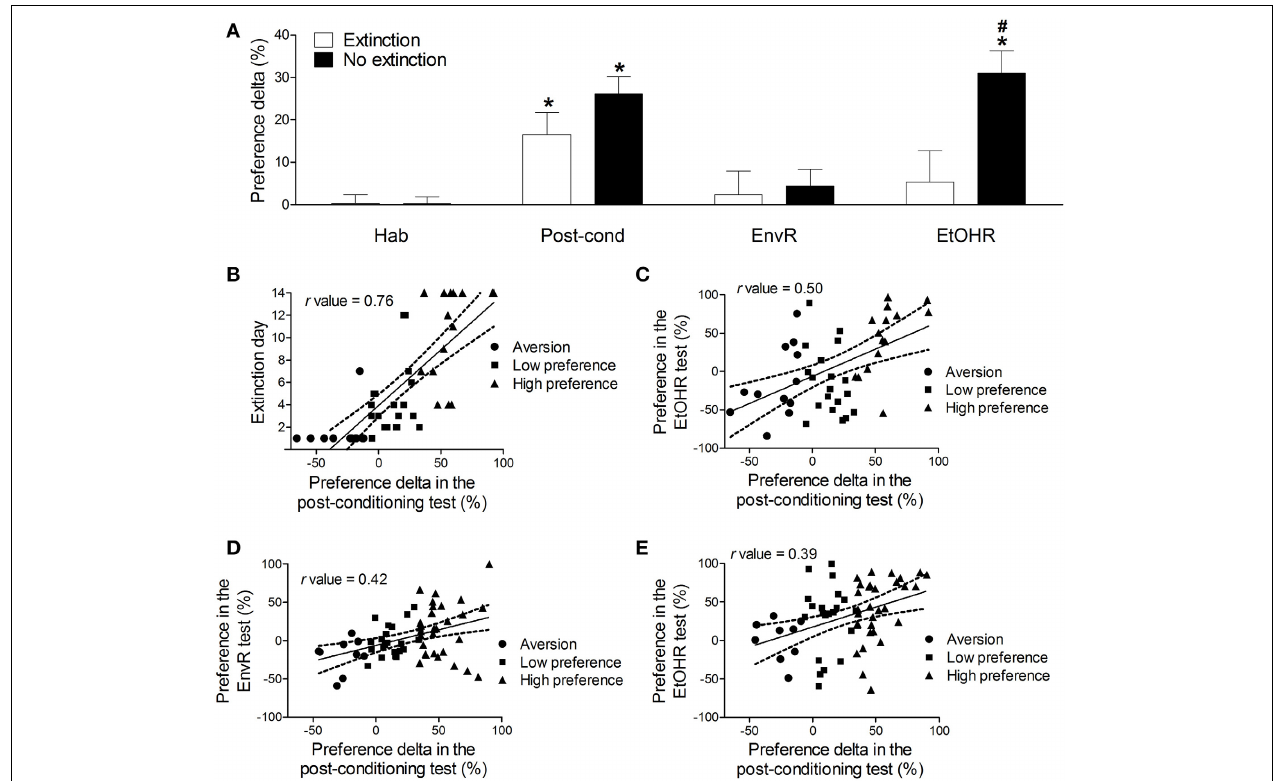
FIGURE 1 | (A) Preference delta for the CS + compartment (mean ± s.e.m) of mice conditioned with 2.2g/kg ethanol from Experiment 2 extinction protocol ( n = 47) and no extinction protocol ( n = 61) in the habituation (Hab), post-conditioning test (Post-cond), environmental reinstatement (EnvR) and ethanol “priming” reinstatement (EtOHR). Preference delta was obtained throughthepercentageoftotaltesttimespentintheCS+compartmentminus the percentage of total test time spent in the CS- compartment in each test. ∗ Significantly higher preference delta than in habituation test ( P < 0 . 05). #Significantly higher preference than the extinction group in the same test ( P < 0 . 001). (B) Pearson’s correlation ( r = 0 . 76, P < 0 . 05) between the preference delta in the post-conditioning test and the number of days required toreturntothe95%confidenceintervalofpreferencedeltahabituationlevelsin